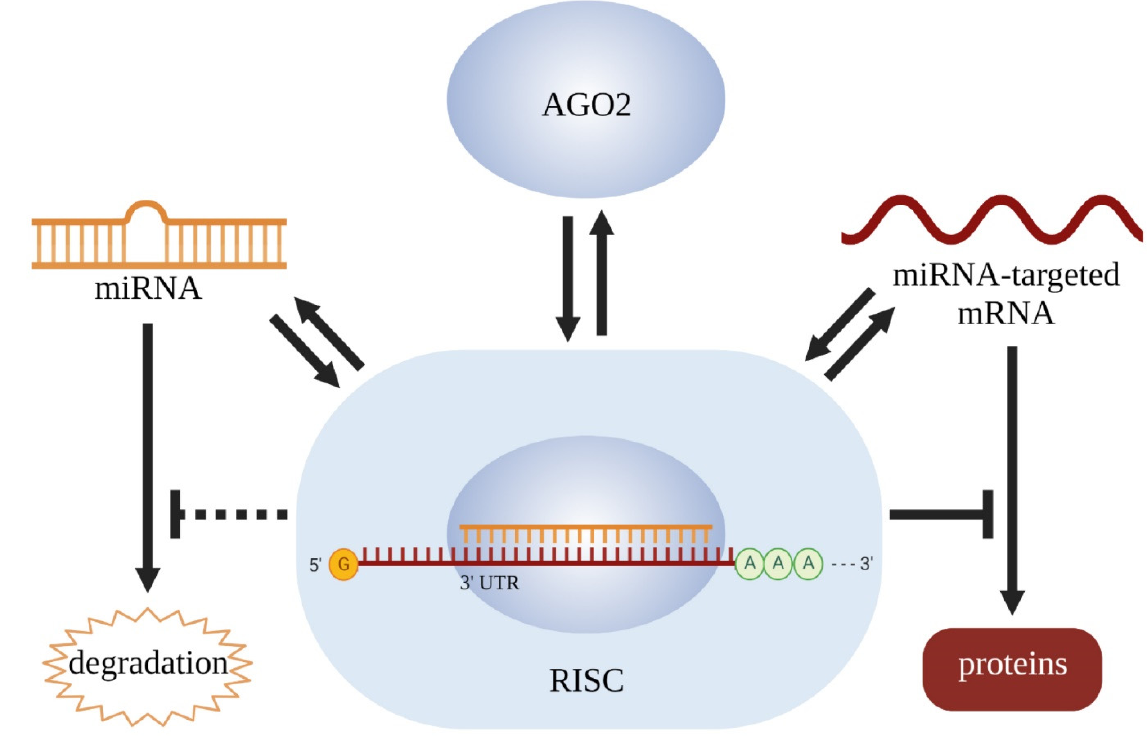
Figure 7. Diagrammatic representation of observed relationships between tissue-specific miRNA and targeted mRNA expression.